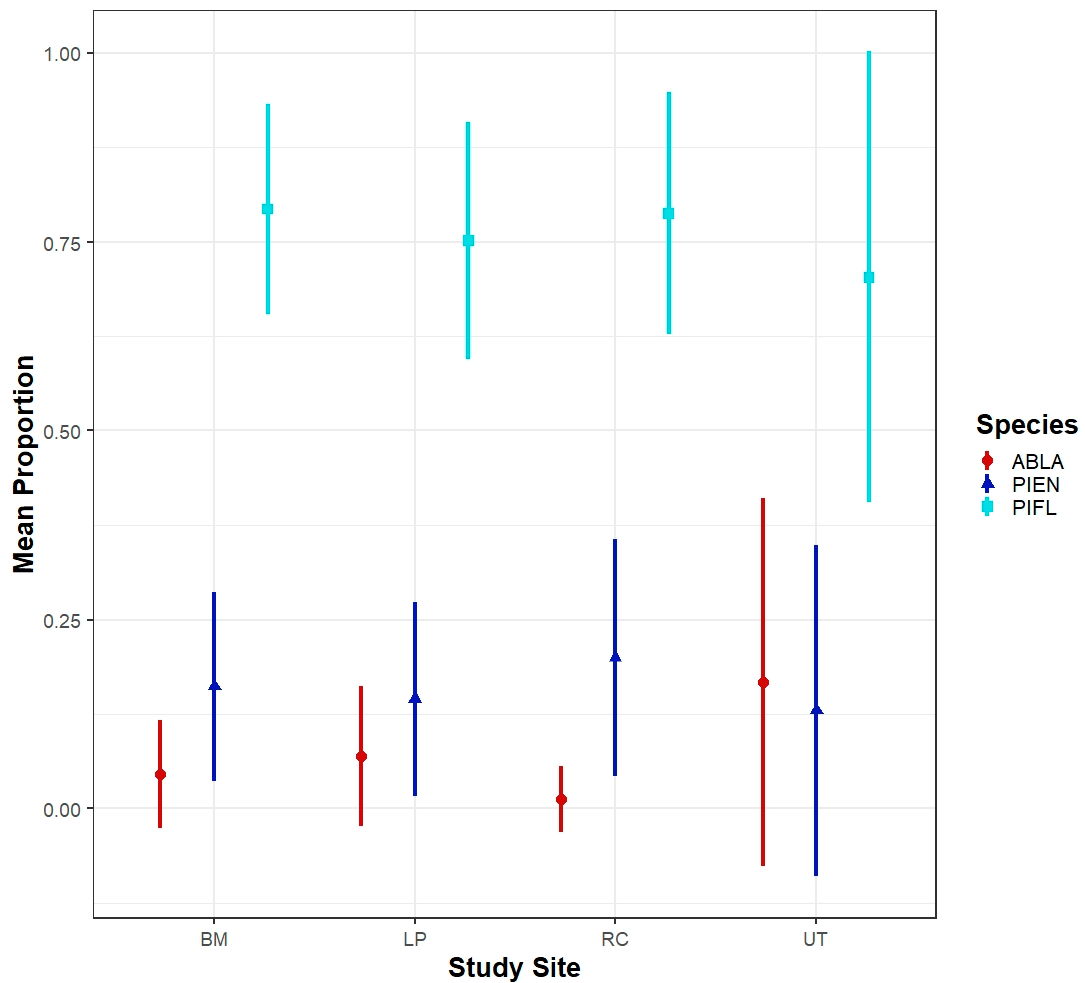
Figure 7. Mean species proportions and 95% confidence intervals for solitary plots are shown for subalpine fir (ABLA), Engelmann spruce (PIEN), and limber pine (PIFL) at the Battle Mountain (BM), Longs Peak (LP), Rainbow Curve (RC), and Ute Trail (UT) study sites. Where confidence intervals do not overlap, differences are significant at the α = 0.05 threshold.